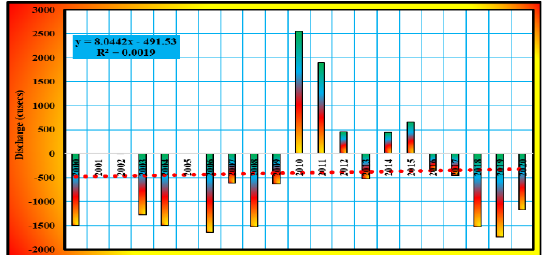
Figure 17: Represents Autumn Season Temperature Trend Line in